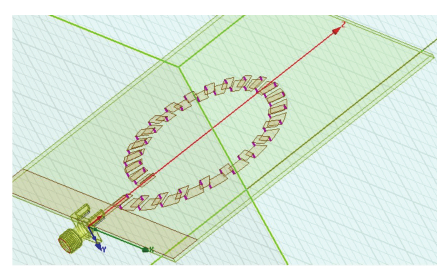
Figure 5: Perspective